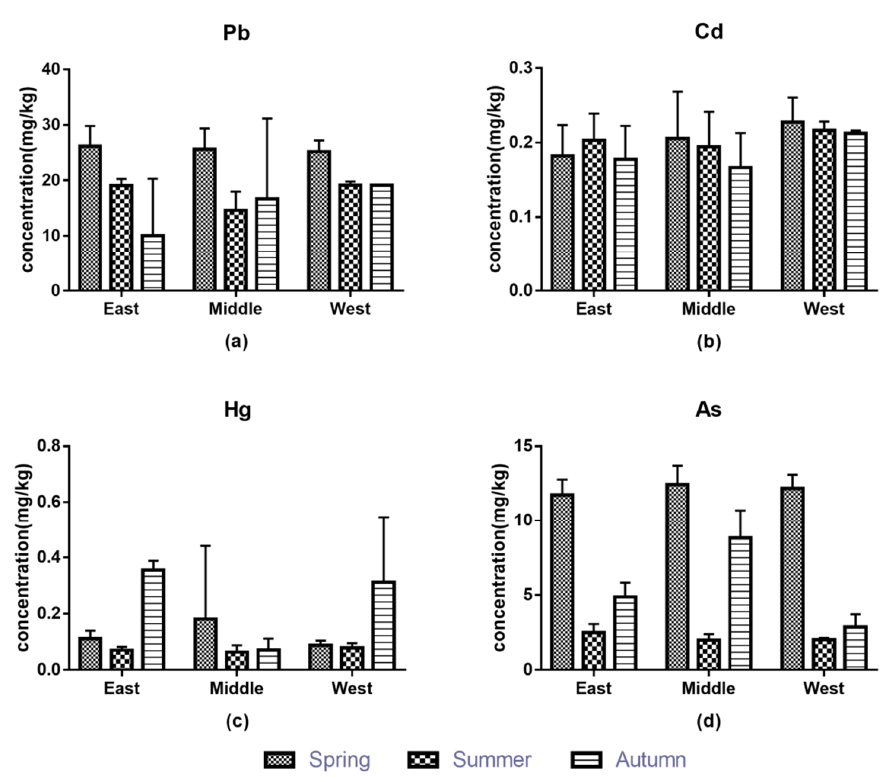
Figure 3. The contents of metals in soil: ( a ) Pb, ( b ) Cd, ( c ) Hg, ( d )